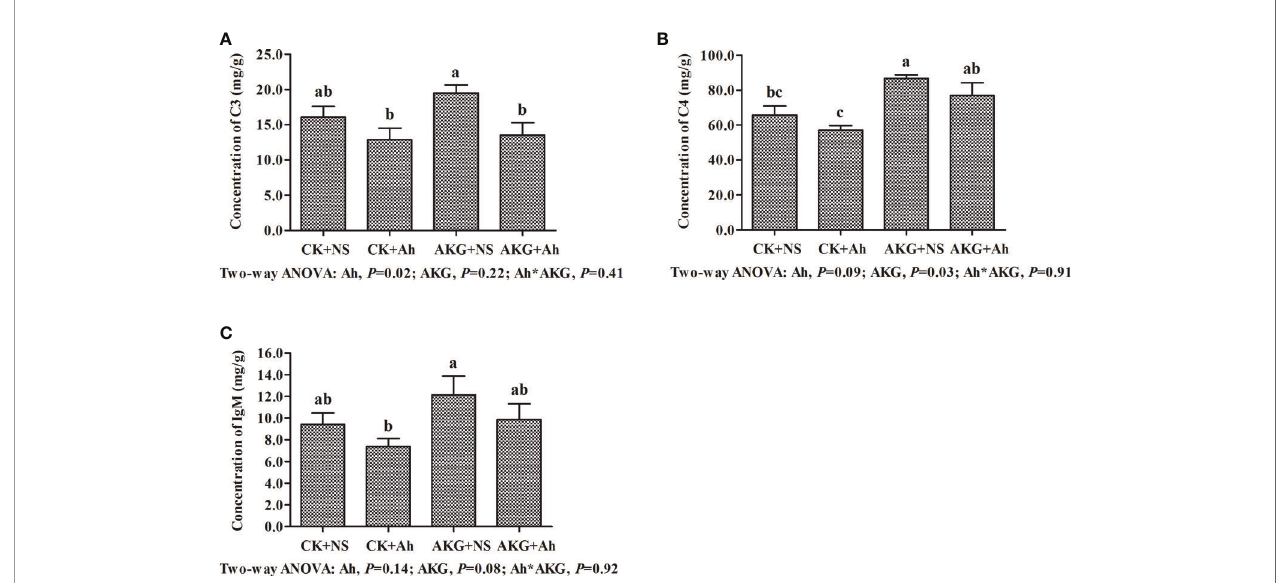
FIGURE 3 | Effects of AKG supplementation and A hydrophila infection on immune-related parameters complements in intestine of Songpu mirror carp ( Cyprinus carpio ). (A) complement C3; (B) complement C4; (C) IgM, immunoglobulin M. All of the values are expressed as the means ± SEM. Values with different letters are signi fi cantly different ( P < 0.05).